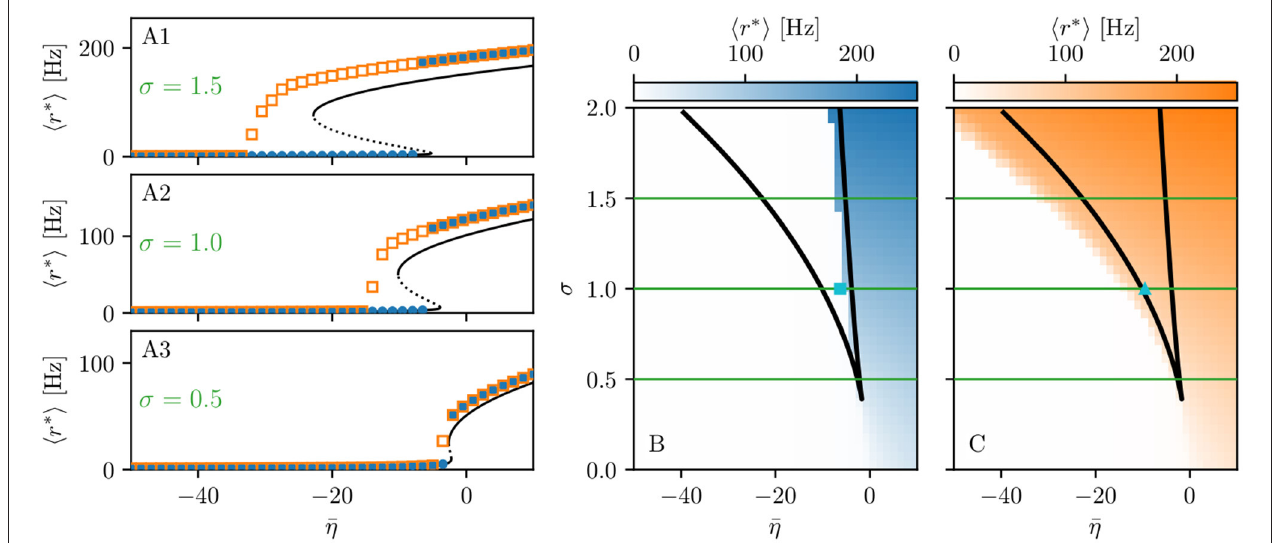
r * η for the up sweep (blue dots) and down-sweep (orange squares). vs. ¯ (cid:11) (cid:10) 1.5 (A1) , σ 1 (A2) , and σ 0.5 (A3) . The solid (dashed) black line = = = r * η showing the network average color-coded for up- ¯ (cid:11) (cid:10) [0,2] in steps of 1σ 0.05. The black line indicates the single-node map ∈ = η 6.3, 9.54, respectively. Parameter values: N pop 90, τ m 20 ms, ¯ = − − = =